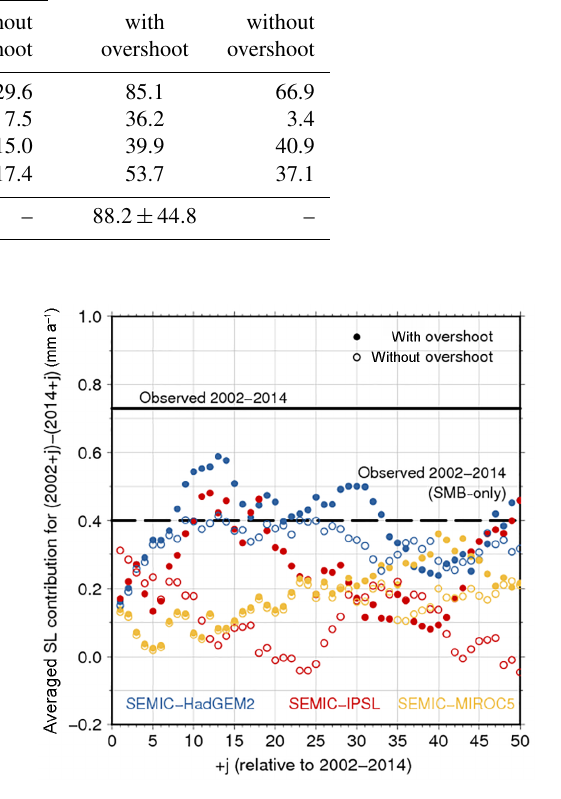
Figure 12. Lag ( j ) of projected sea-level rise per year under RCP2.6 forcing (coloured dots) and the modified RCP2.6 forcing without overshoot (coloured circles) as a mean for a time period similar to the observational period (2002–2014). The solid black line indicates the observed value of 0.73mma − 1 by Rietbroek et al. (2016) and the dashed line the observed value of 0.40mma − 1 cal- culated from RACMO2.3 for the period